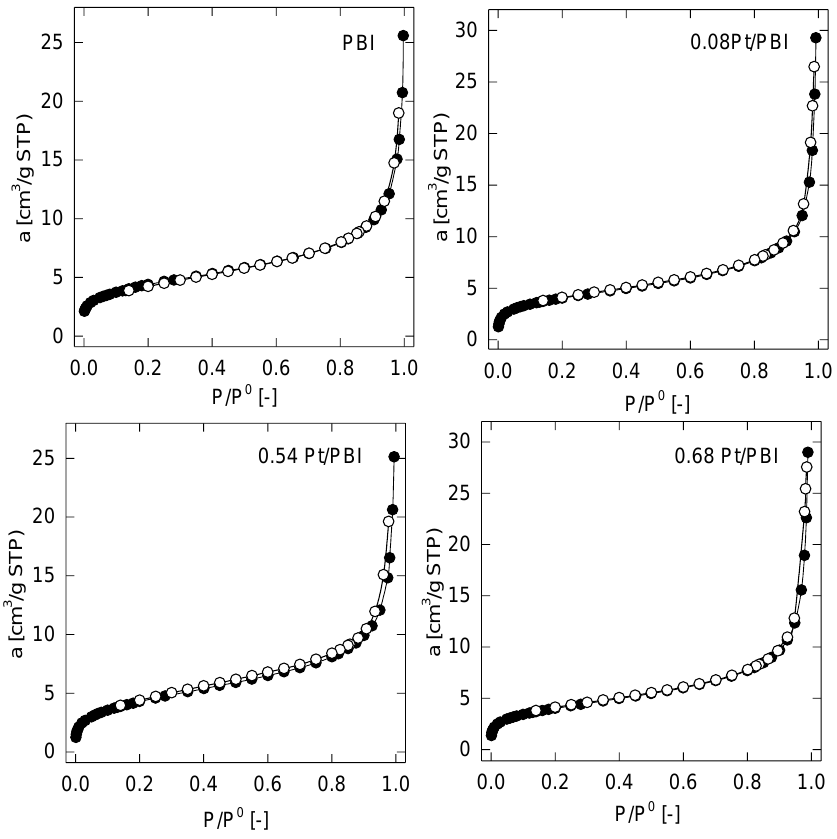
Membranes 2023 , 13 , x FOR PEER REVIEW Figure 5. Adsorption ( ● ) and desorption (o) branches of the nitrogen sorption isotherms at 77 K. Figure 5. Adsorption ( • ) and desorption (o) branches of the nitrogen sorption isotherms at 77 K. Table 1. Textural characteristics of the parent electrospun membrane and catalysts.